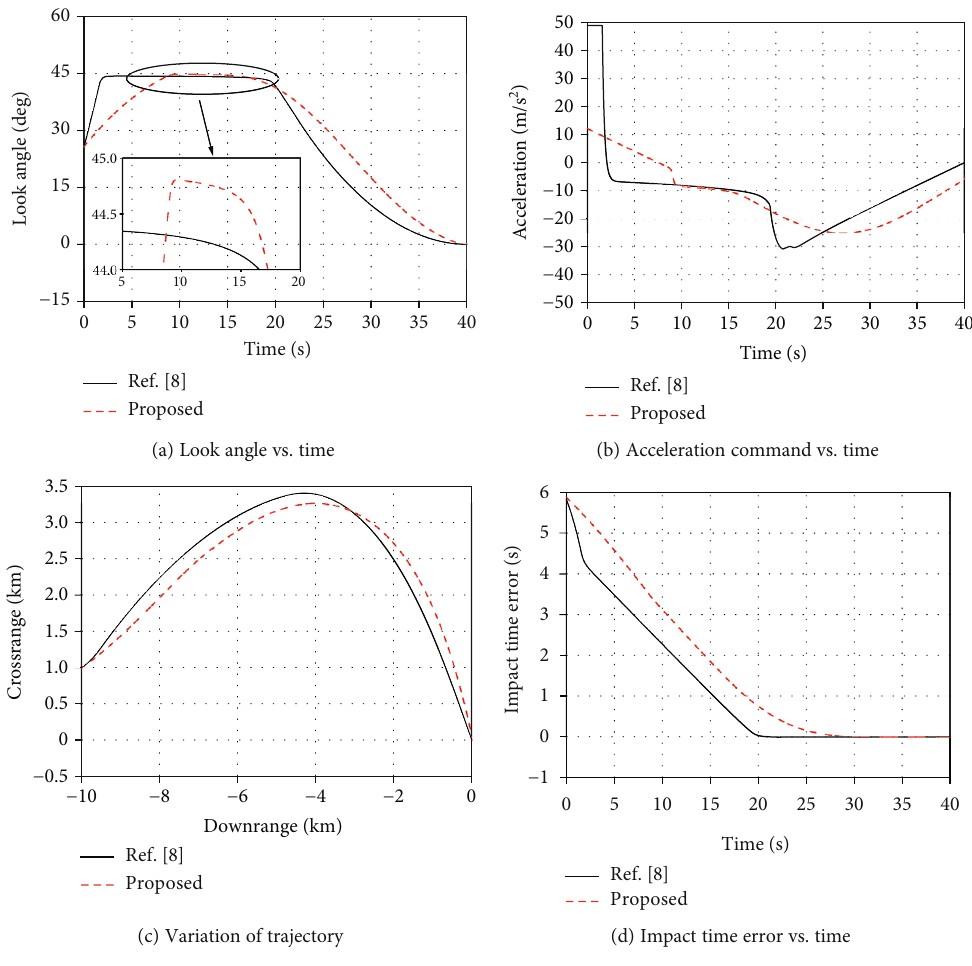
Figure 5: Simulation of ITCG laws with fi eld-of-view